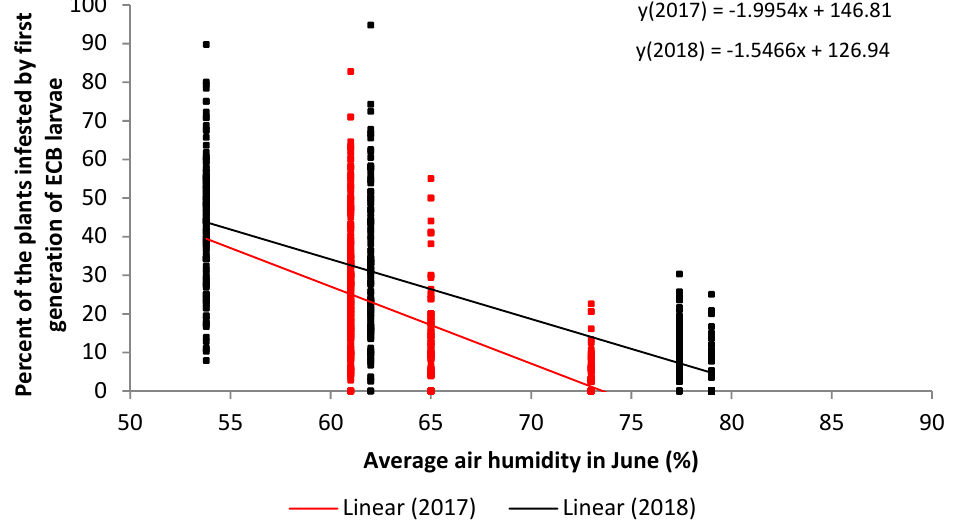
Figure 2. Regression analysis of the average air humidity in June (x) versus the percent of infestation with first generation of ECB larvae (y) in two years (2017—red and 2018—black).